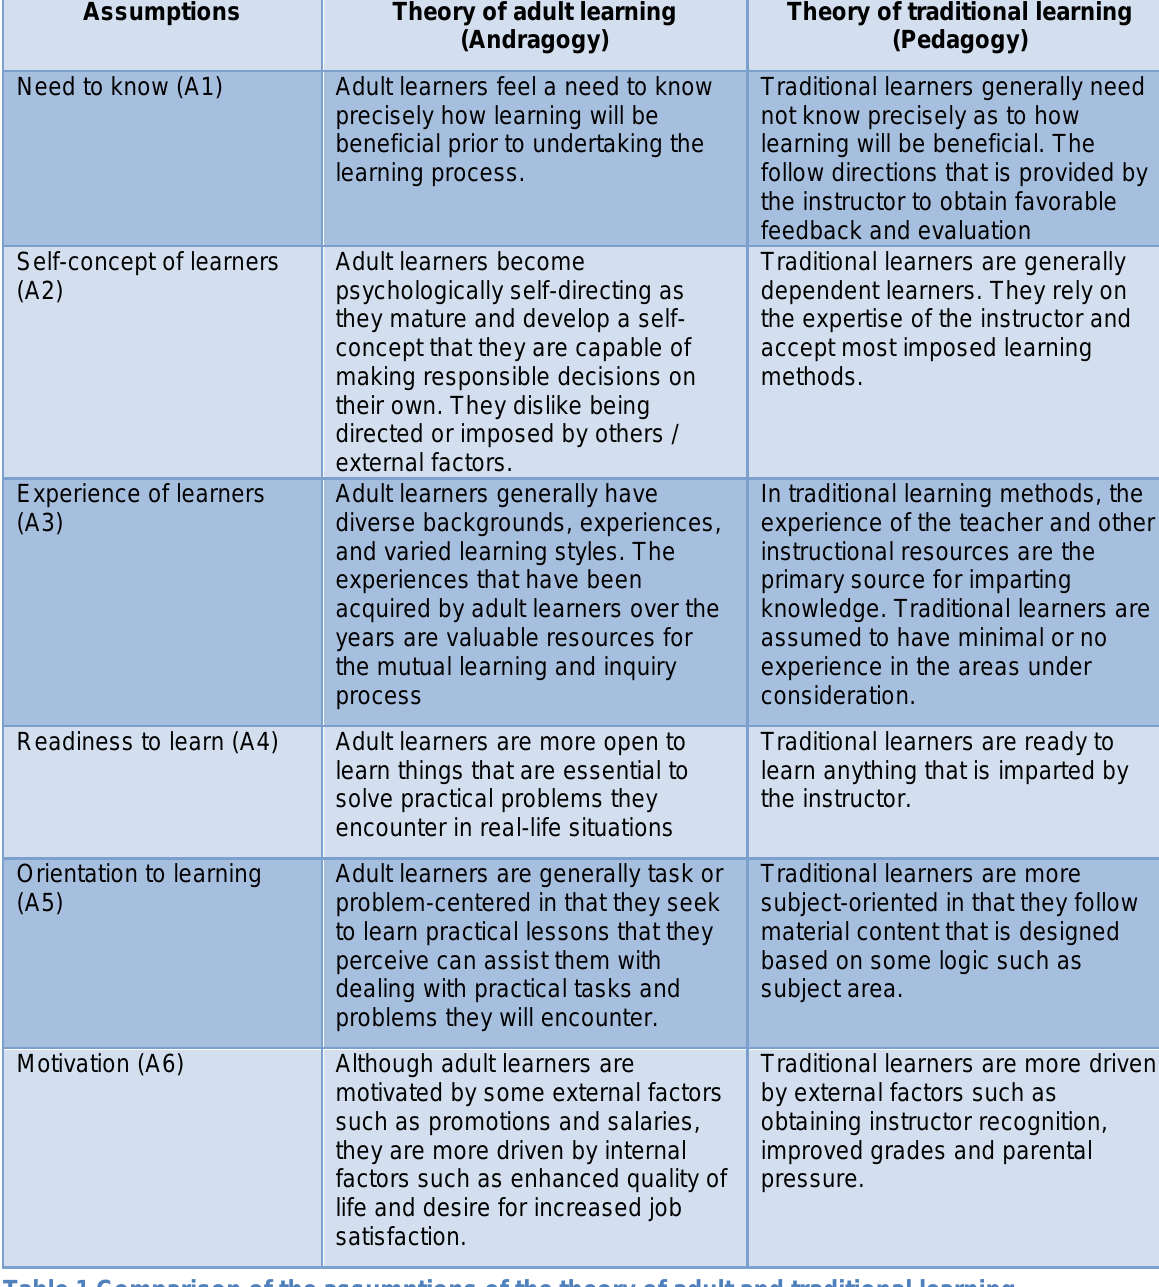
Table 1 Comparison of the assumptions of the theory of adult and traditional